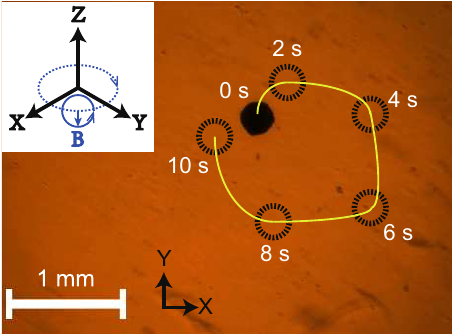
Figure 9. Snapshots of driving a magnetic micro-ball in a Petri dish filled with pure water. Black circle—position of the magnetic microball; yellow curve—actual trajectory; top-left inset—actuation magnetic field.